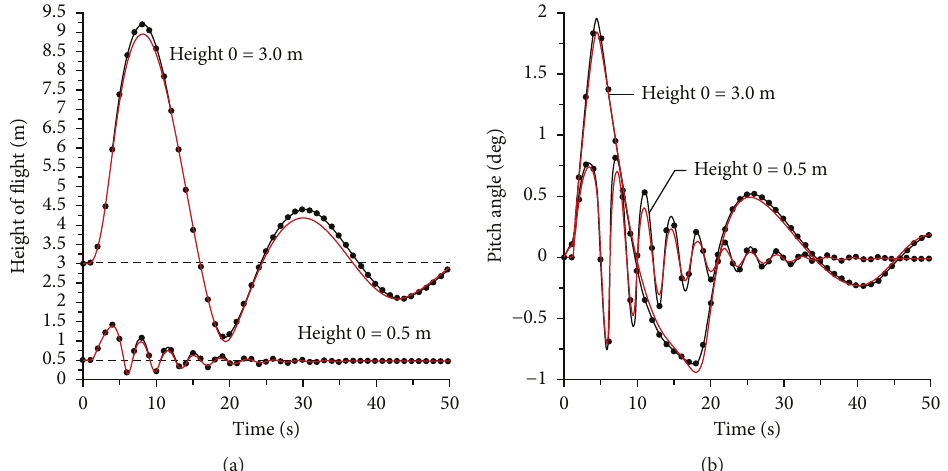
Figure 11: Trajectory of the WIG craft under sinusoidal wind perturbations w with circles correspond to the simulation with quasi-steady determination of forces.